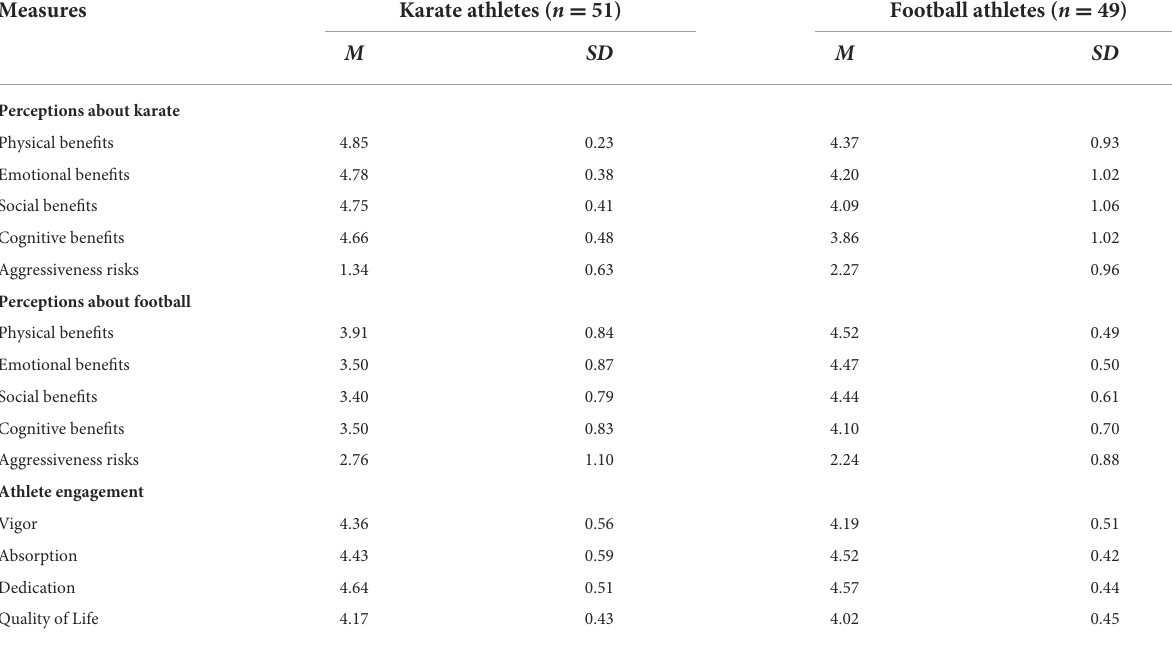
TABLE 2 Means and standard deviations for perceptions, engagement, and quality of life for karate and football athletes.